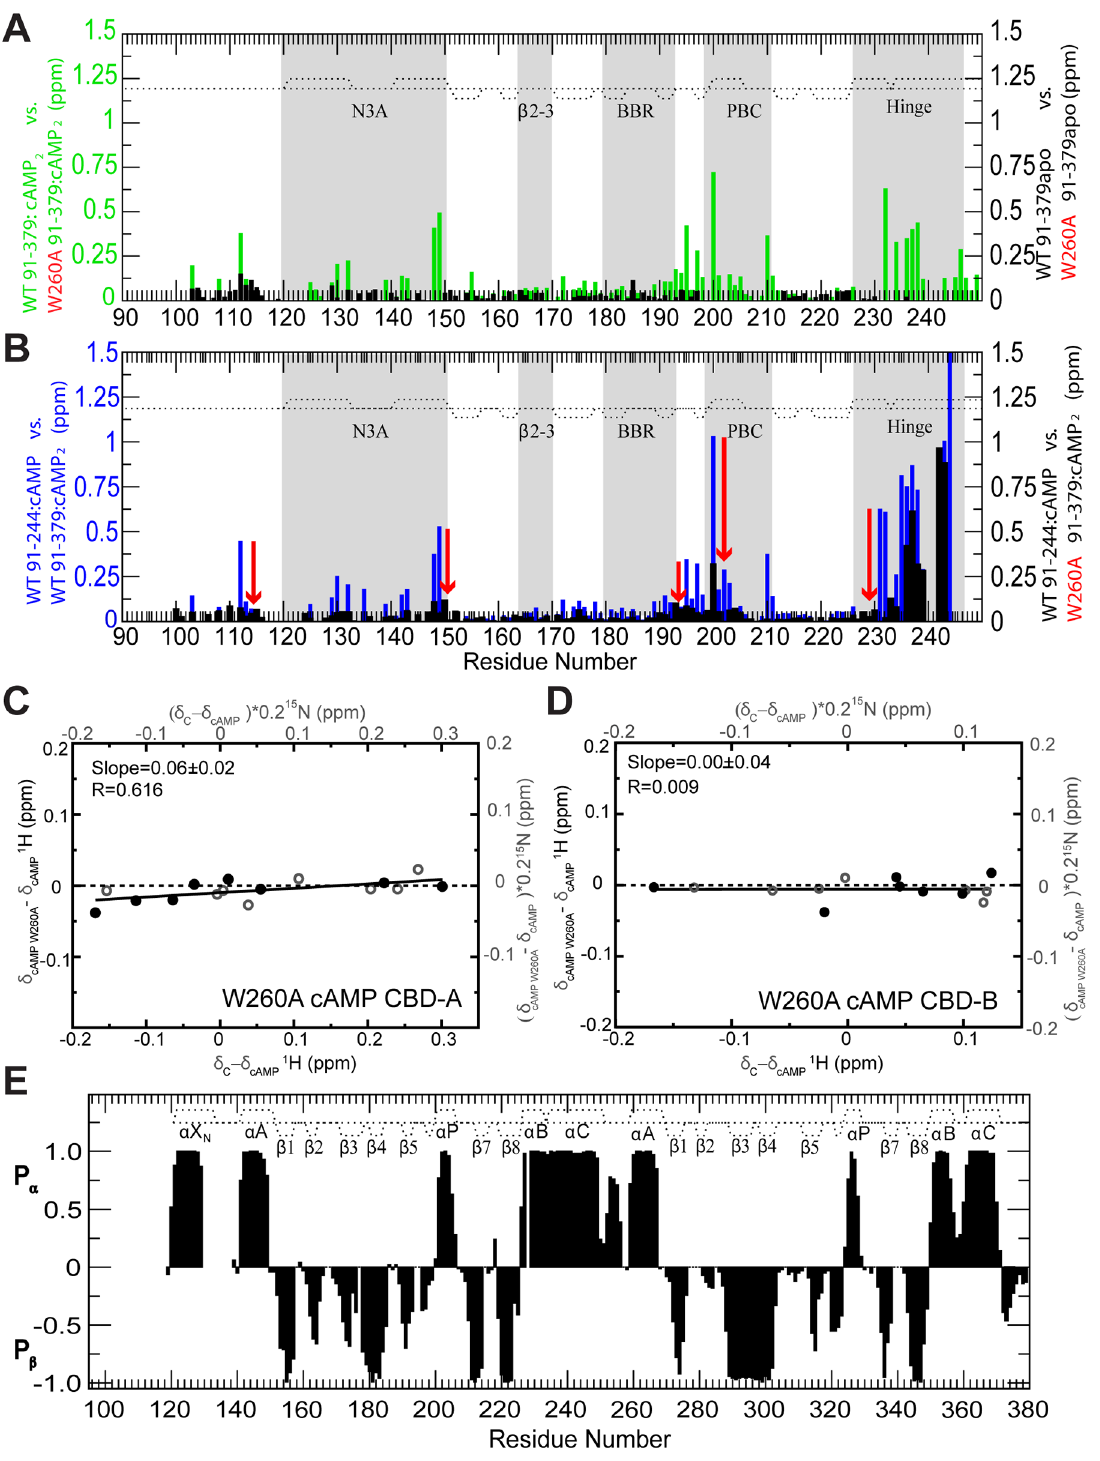
Fig 4. Probing CBD-A/B interactions in RI α (91 – 379) through the W260A mutation. Evaluation of the effect of the W260A mutation on the CBD-A/B interface through CCS differences in the apo and cAMP-bound states. (A) CCS changes caused by the W260A mutation in RI α (91 – 379) apo (black) or cAMP 2 -bound (green). (B) Plot of WT cAMP-bound RI α (91 – 244) versus WT cAMP 2 -bound RI α (91 – 379) CCS differences (blue) and plot of the WT cAMP- bound RI α (91 – 244) versus W260A cAMP 2 -bound RI α (91 – 379) CCS differences (black). The red arrows illustrate the effect of the W260A mutation. The comparison of the black and blue CCS difference profiles shows that the W260A mutation mimics the deletion of CBD-B. (C) Effect of the W260A mutation on